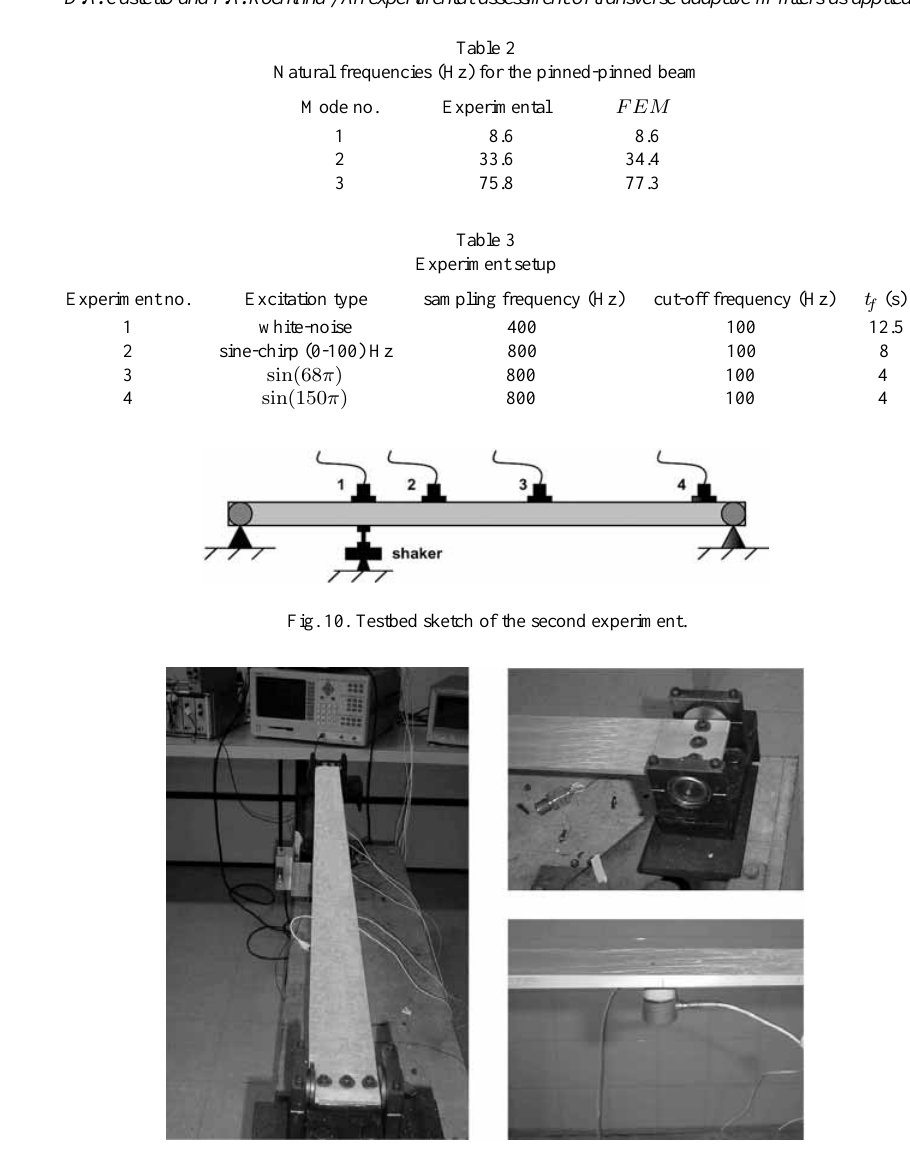
Fig. 11. Experimental setup (second